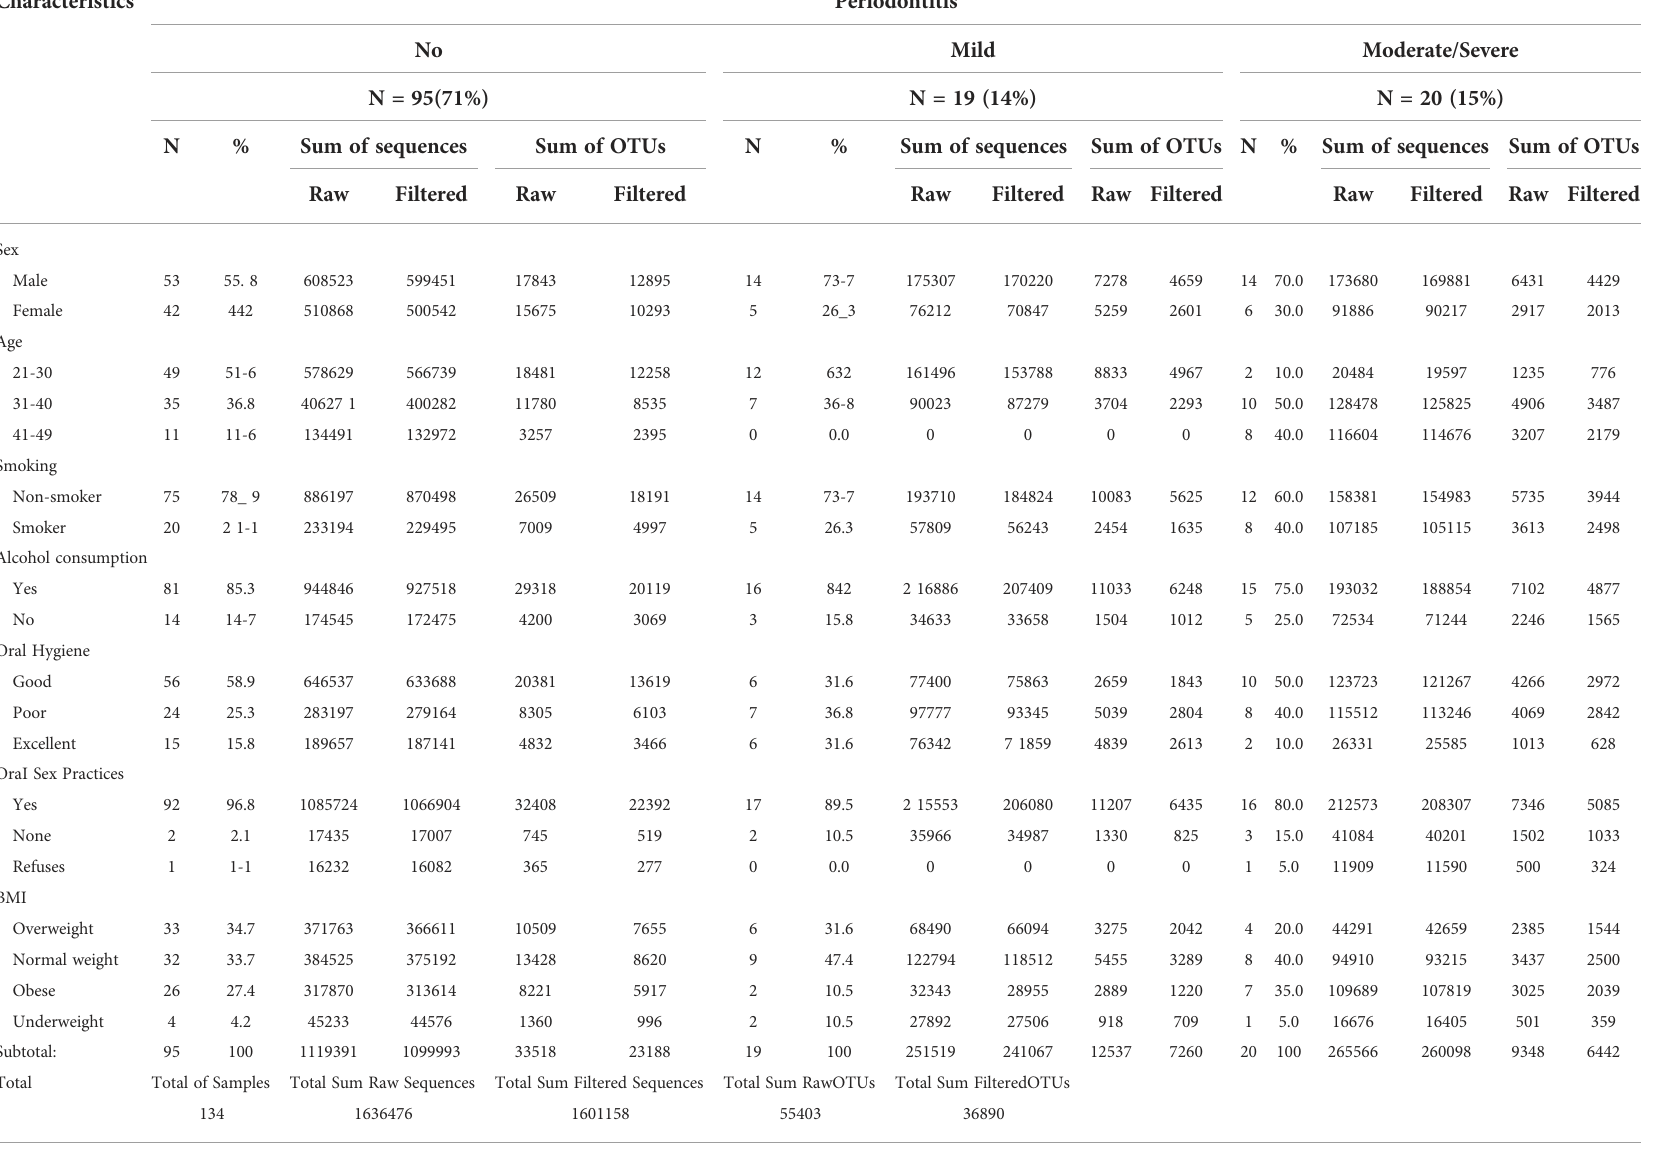
TABLE 1 Clinical and behavioral characteristics by periodontal severity categories.